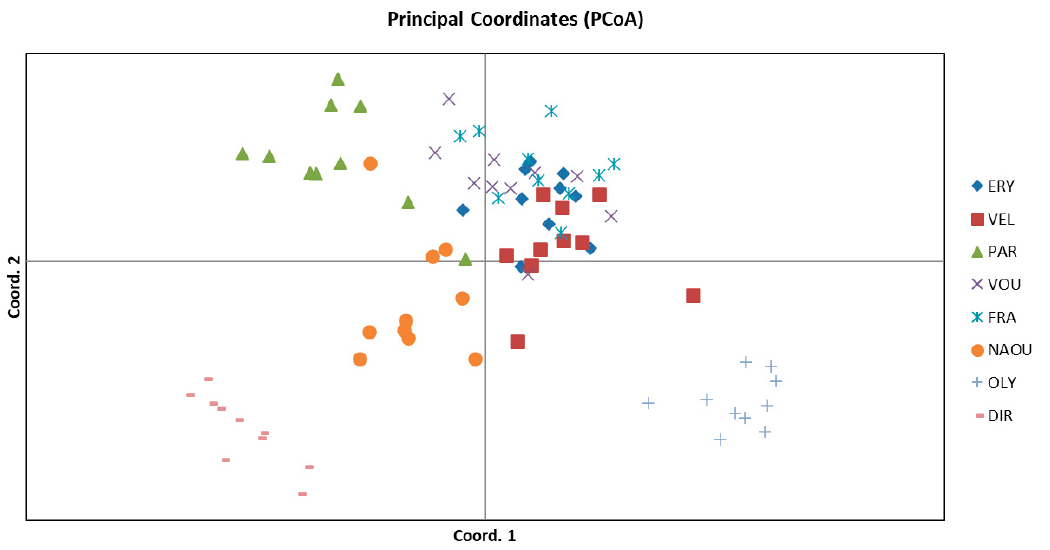
Figure 1. A two-dimensional plot of the principal coordinates analysis (PCoA) of ISSR data showing the clustering of the populations.